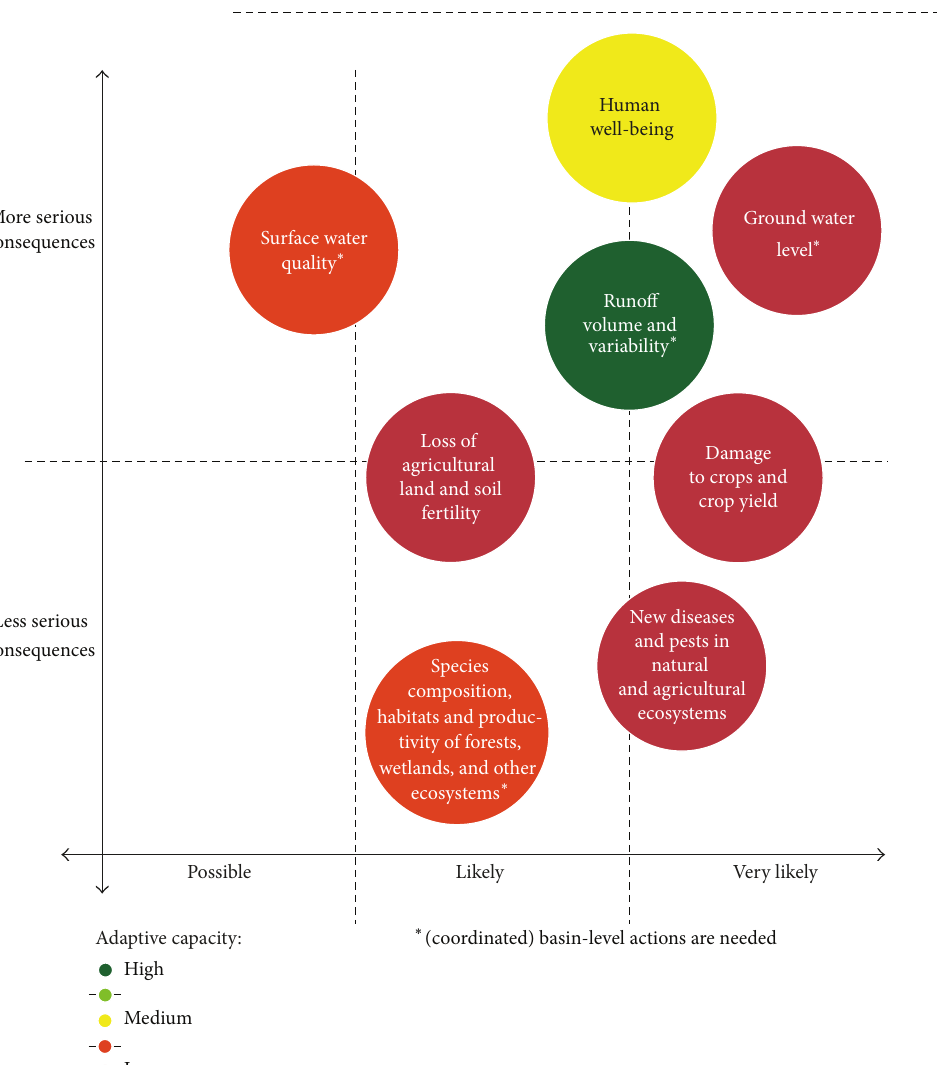
Figure 4: Graphical summary of the participatory analysis of inputs to the Dniester basin vulnerability to climate change according to the severity of consequences and their probability (design by Carolyne Daniel, Zo¨ı environment network,